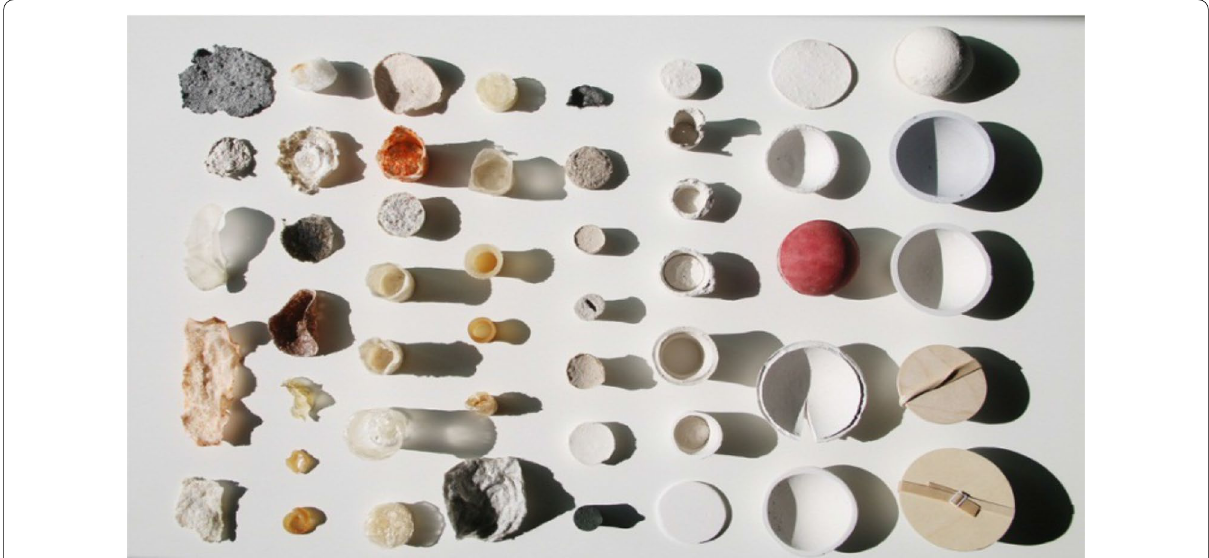
Fig. 2 Various materials and shapes in zero experimental waste packaging by Austeja Platukyte. Source: https:// www. behan ce. net/ galle ry/ 38533 363/ exper iment al- packa ging- from- biode grada ble- mater ial downloaded on March 28,